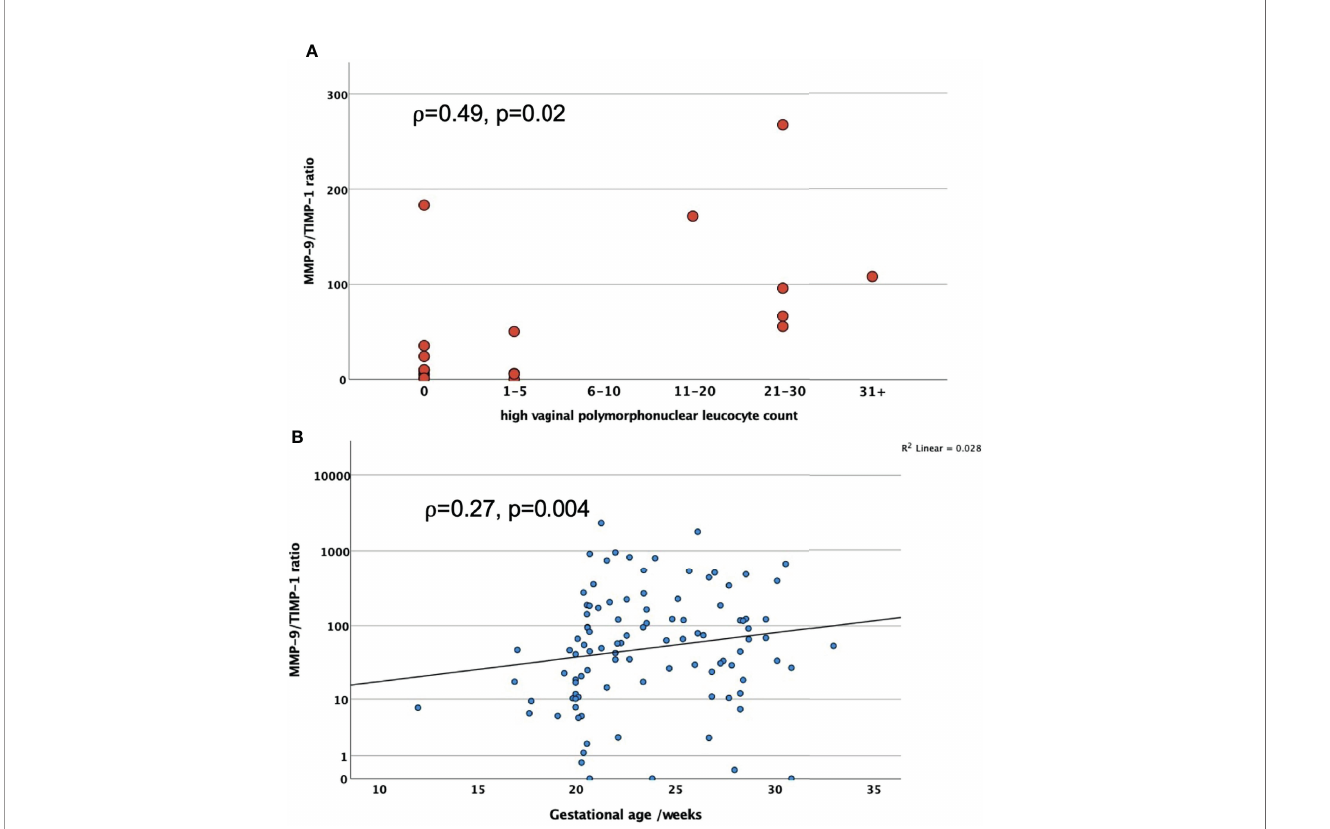
FIGURE 5 | (A) Scatter graphs to explore correlation of CVF MMP-9/TIMP-1 ratio with polymorphonuclear leucocyte counts in PWLWH; (B) Scatter graph to show the association between CVF MMP-9/TIMP-1 ratio and gestational age at sampling in PWLWH ⍴ =